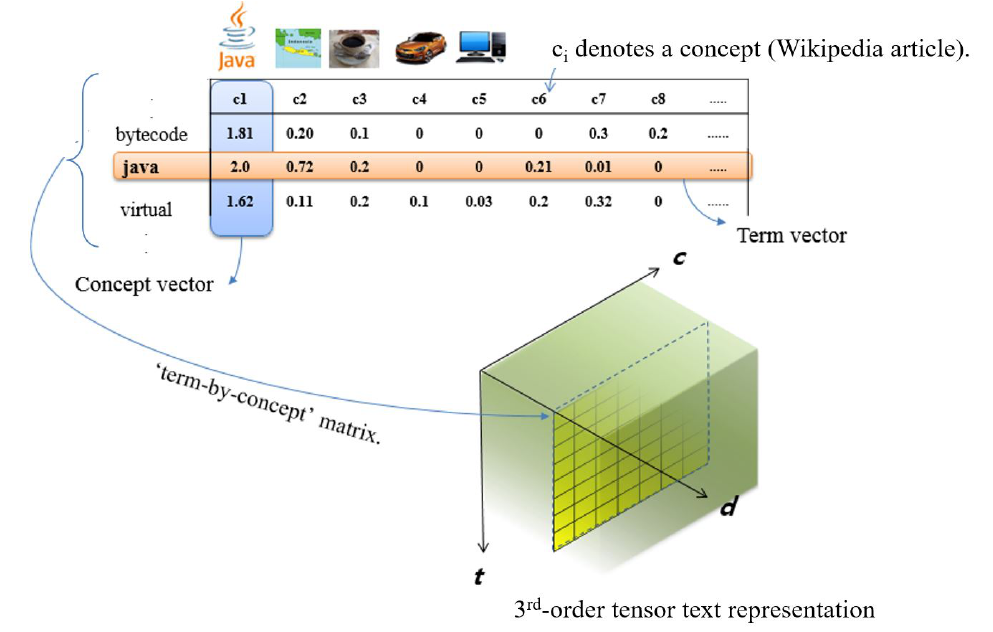
Figure 4. Generating a concept-by-term-by-document tensor.